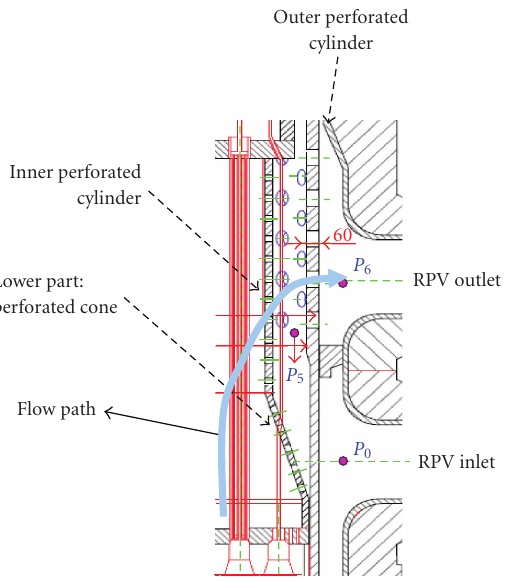
Figure 6: Vertical arrangement of the VVER-1000 primary